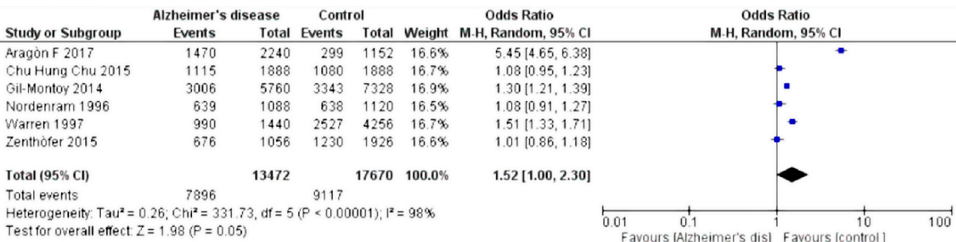
ff ects models of the meta-analysis. Outcome: missing teeth. Dent. J. 2019 , 7 , x FOR PEER REVIEW